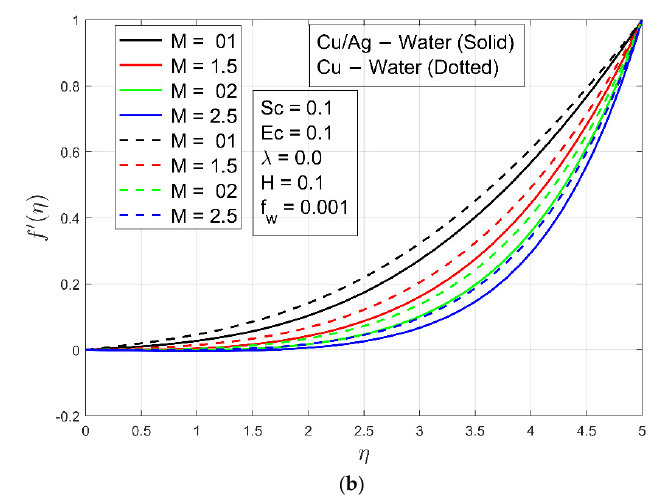
Figure 2. ( a ) Impact of 𝑀 on velocity profile 𝑓 ( 𝜂 ) . ( b ) Impact of 𝑀 on velocity profile 𝑓 (cid:4593) ( 𝜂 ) .